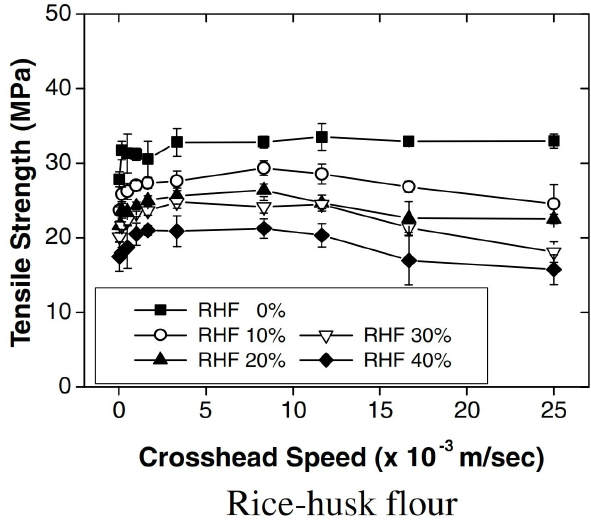
Figure 1: Tensile strength of different wt. Compositions of RH